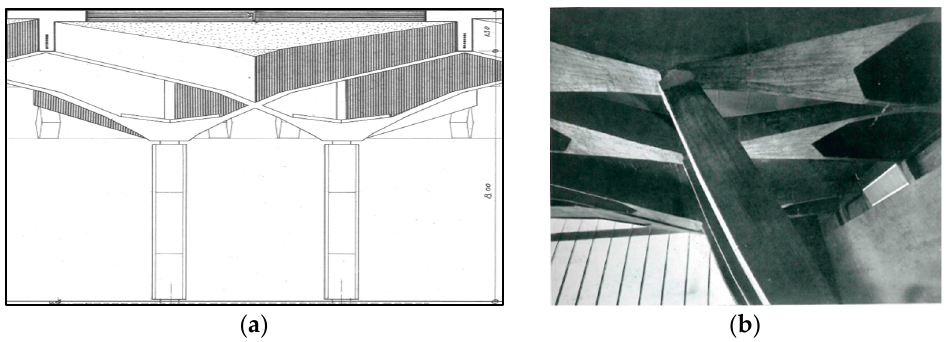
Figure 9. Intersection of the thin ribs creating a dovetail geometry: ( a ) general section; ( b ) detail of the restraints of the shorter strut beams.